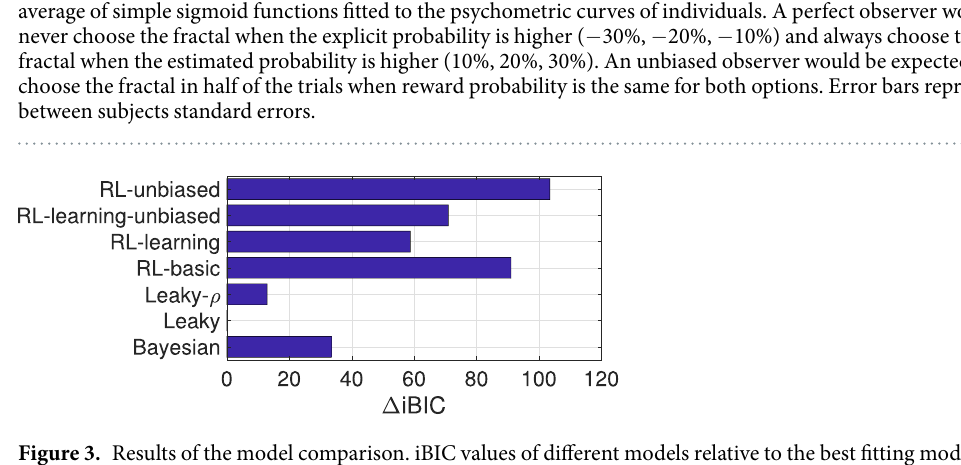
Figure 2 shows the fitted sigmoid curves using the average of the fitted parameters for each group. The fit- ted offset parameter ( α ) was not significantly different between groups ( t (28.1) = 0.023, p = 0.982), but the slope parameter ( β ) was significantly different ( t (26.3) = − 2.383, p = 0.025), with controls having steeper curves ( β controls μ ± σ = 0.566 ± 0.316), indicating they were significantly better at learning ( β patients μ ± σ = 0.350 ± 0.185). Stankevicius and colleagues 14 recorded a systematic bias in optimistic people towards